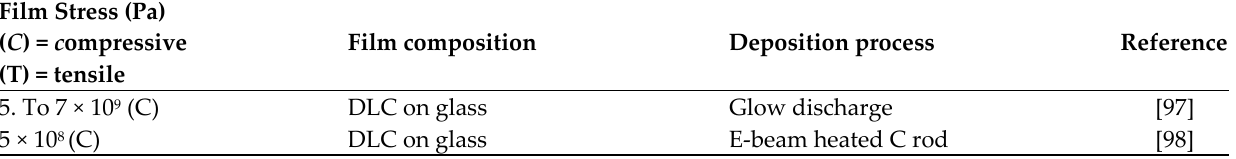
Table 3. Quantitative stress measurements for DLC and diamond